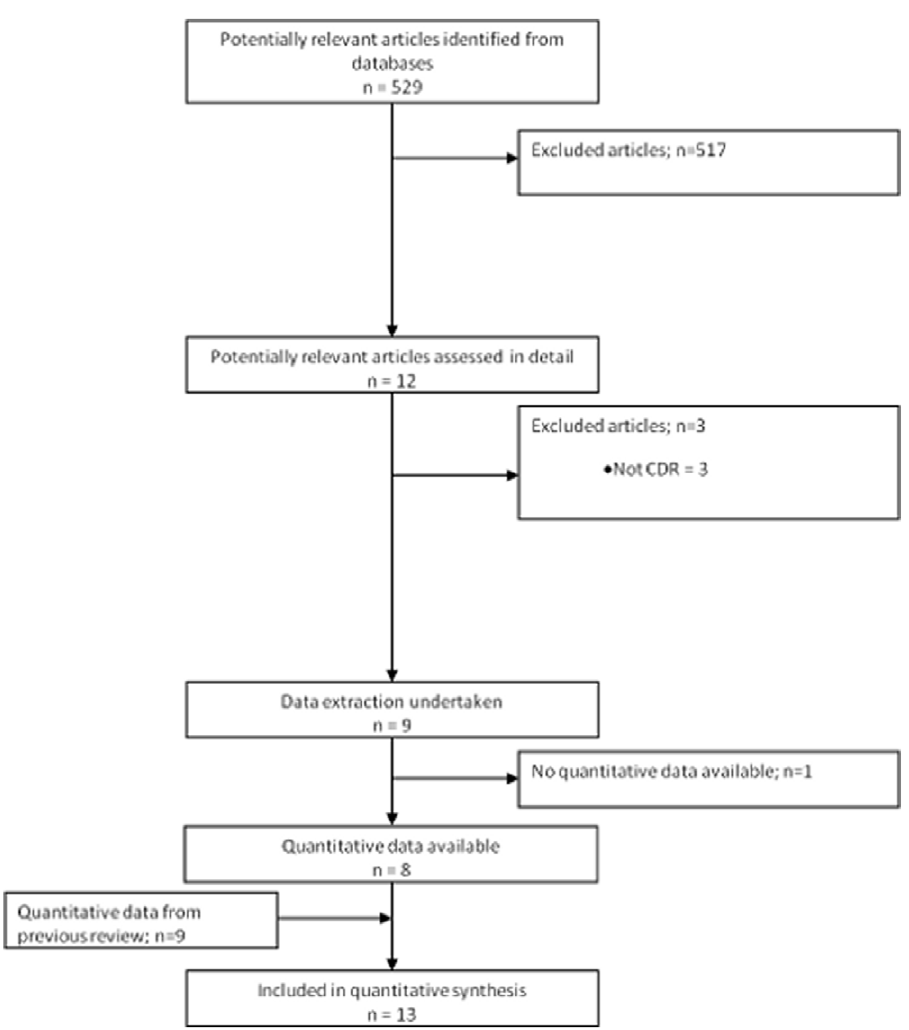
Figure 1. Flowchart of studies through the review.